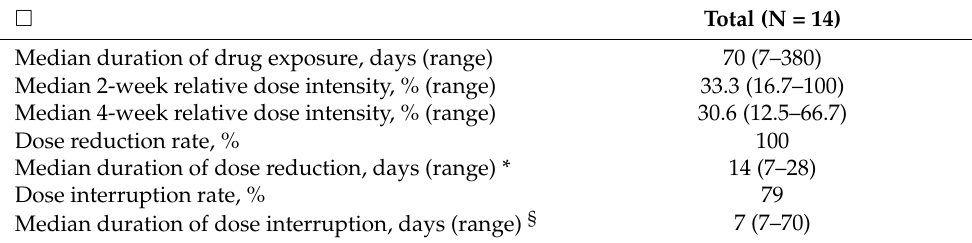
Table 2. Therapeutic details of cabozantinib administration.